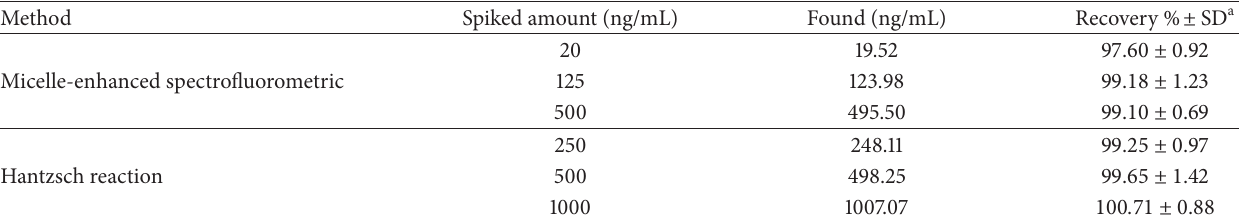
Hantzsch reaction a Mean of five